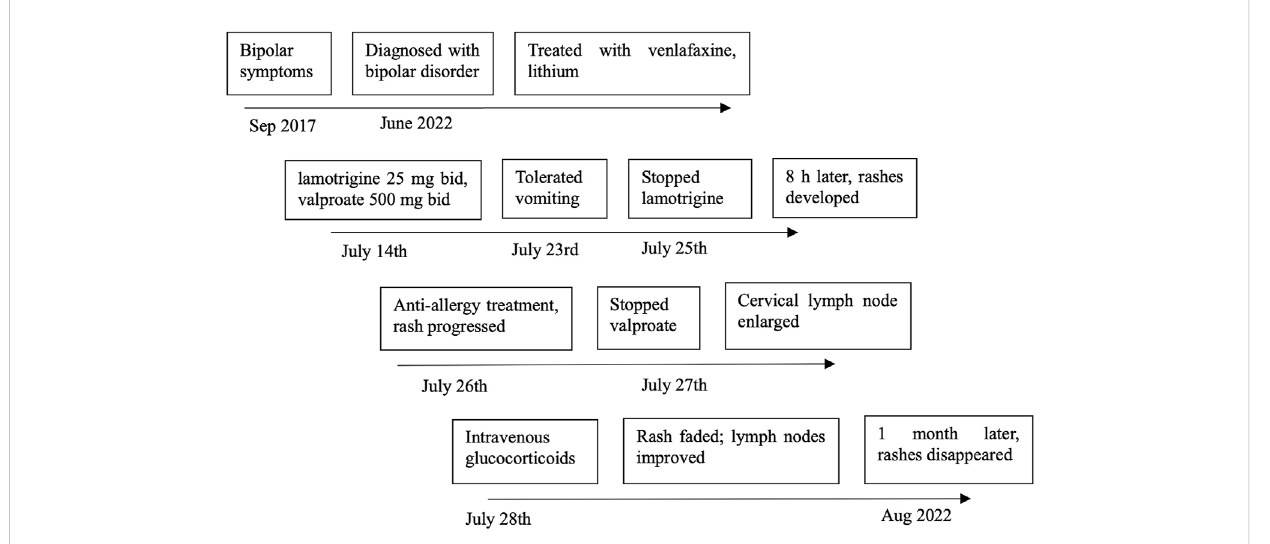
FIGURE 1 Timeline of lamotrigine and magnesium valproate